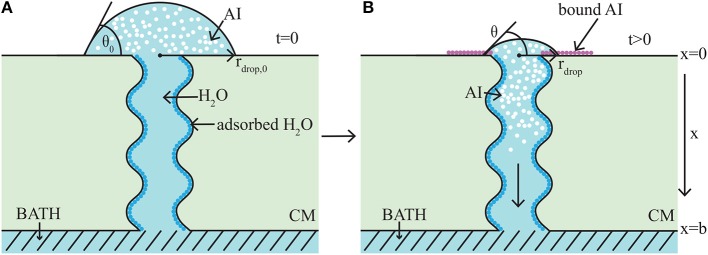
1-D cuticle model domain of AI diffusion and water adsorption-diffusion. The initial conditions of the model are shown on the left (A) and a short time later on the right (B). Diffusion of AI starts at the outer surface (at x = 0), where a drop of solution containing AI and water having initial contact angle, θ0, and radius, rdrop, 0, sits. Over time AI travels through the porous cuticle membrane (CM) to the well stirred water bath at the inner surface (at x = b). Water adsorbs to the surface of the pore (shown as dark blue circles). In (B) at the cuticle surface (at x = 0), AI is trapped on the surface via ion binding, (shown as pink circles) and the droplet solution has undergone some evaporation and both the contact angle, θ, and radius, rdrop, have changed. For simplicity, a single tortuous aqueous pore can be seen crossing the cuticle (not to scale). Figure adapted from a figure published in Tredenick et al. (2017). The article was published under a Creative Commons CC-BY license.